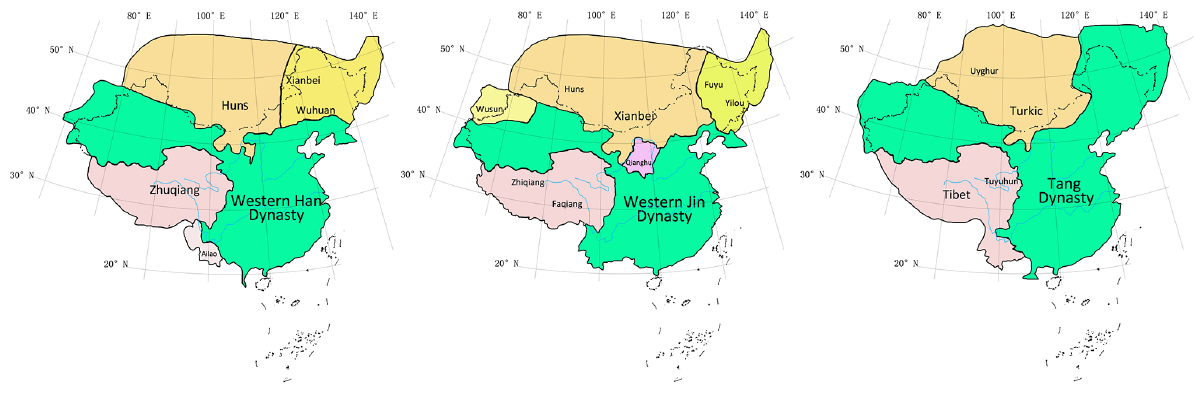
Figure 1. Distribution of the regions of the nomadic and farming groups during the Western Han Dynasty, the Western Jin Dynasty, and the Tang Dynasty (Tan, 1982). Note: regions in which farming groups became established in different periods are in green. Regions identified with other colours correspond to different systems established by several nomadic